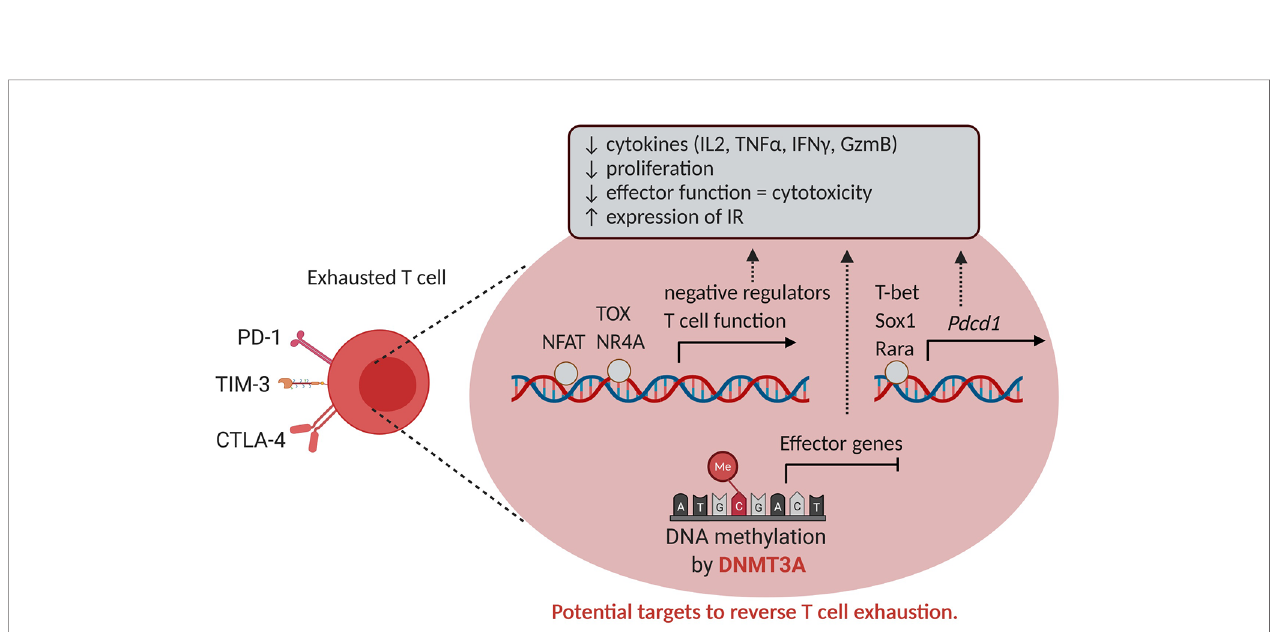
FIGURE 6 | Epigenetics and T cell exhaustion. T cell exhaustion is characterized by reduced T cell proliferation, effector functions and increased expression of inhibitory receptors such as PD-1, CTLA-4 and TIM-3. The expression of these inhibitory receptors in CD8 + tumor-in fi ltrating cells is enabled altered chromatin accessibility and binding of transcription factors such as NFAT, TOX, NR4A, T-bet, Sox1 and Rara in genes exerting a negative role for T function. In addition, DNMT3A mediates DNA methylation and silencing of effector genes, hence serving as a potential target to reverse T cell exhaustion. IR, inhibitory